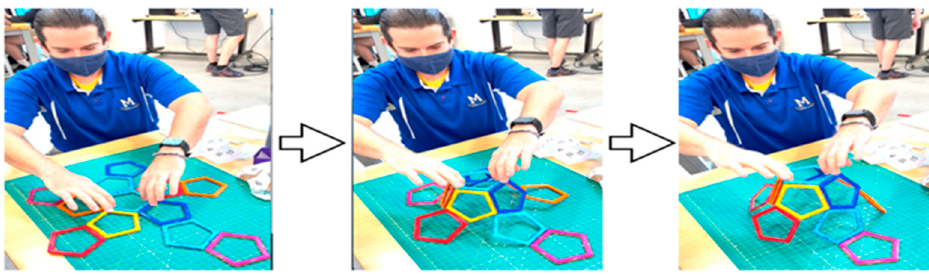
Figure 6. Radial Serial Folding: Middletown, DE high school teacher Matt Juck demonstrated how one Durer net planar configuration of a dodecahedron made with Magformers TM [3] easily folded into a 3D polyhedron.